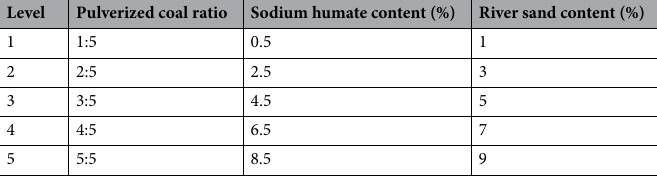
Table 2. Regressional orthogonal experiment design.